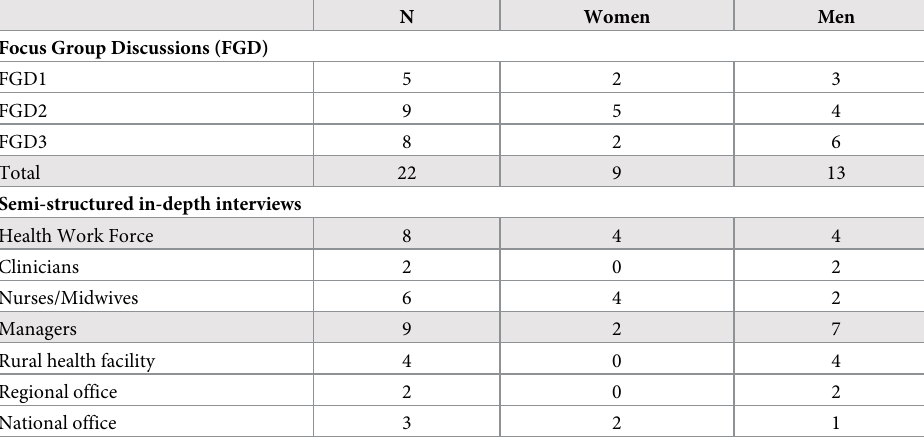
Table 1. Distribution of study participants based on